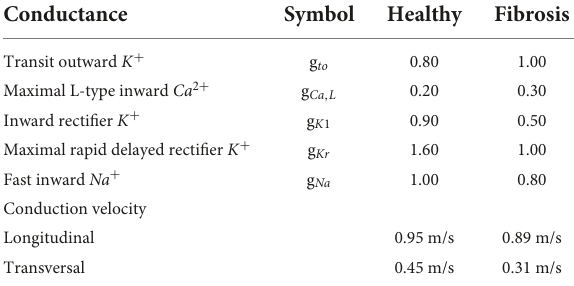
TABLE 1 Ionic conductivity multiplicators and conduction